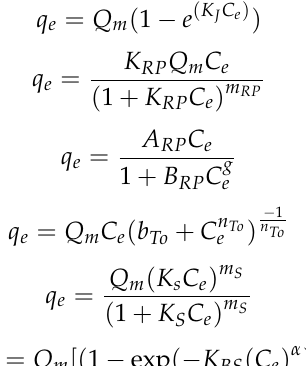
Table 5. Statistical parameters for adsorption isotherm model fitting.